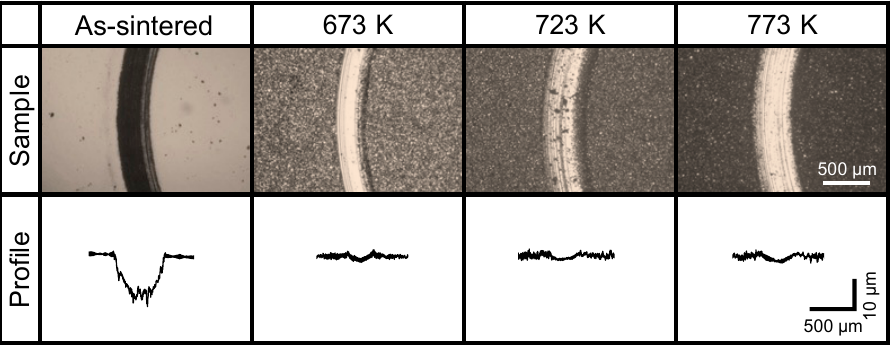
Figure 13. Wear track and its cross-sectional profile for plasma-nitrided CoCrFeMnNi samples after the wear test.